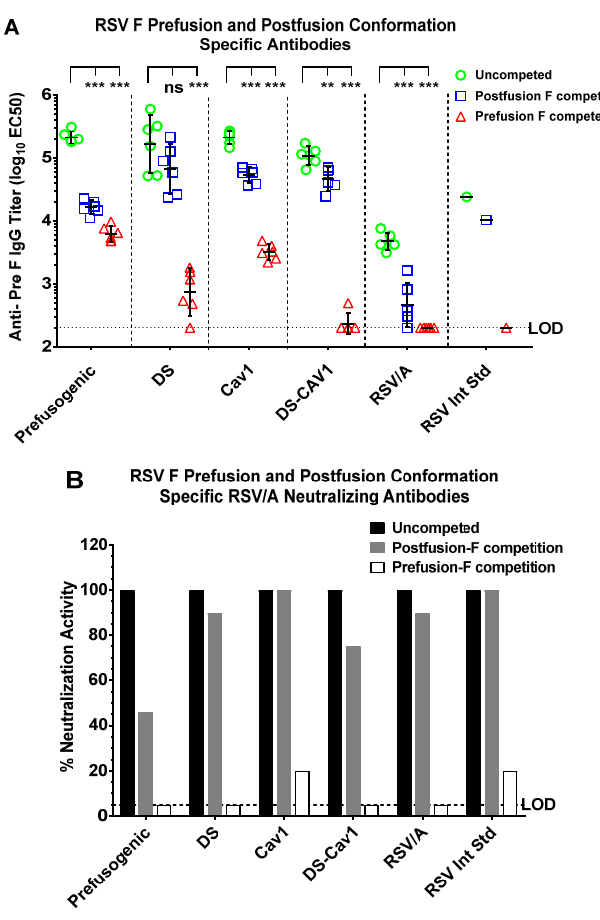
Figure 5. Prefusion and postfusion F specificity of antibodies elicited by prefusogenic F and prefusion F variants. Cotton rats were immunized on days 0 and 21, and serum analyzed 21 days after the second immunization (day 42) as described in Figure 4. ( A ) A competitive ELISA was used to determine the level of antibodies targeting prefusion F (BV2129) and postfusion F (BV2128) in serum of immunized cotton rats. Individual animal titer is indicated by the colored symbol for each immunization group. The geometric mean titer (GMT) is indicated by the horizontal bar and the error bars indicate the 95% CI. ( B ) Conformation-specific neutralizing antibodies in serum competed with prefusion (BV2129) or postfusion F (BV2128). The group (N = 6 per group) GMT is indicated by the solid bars. Lower limit of detection (LOD). ** p = 0.003, *** p < 0.0001, not significant